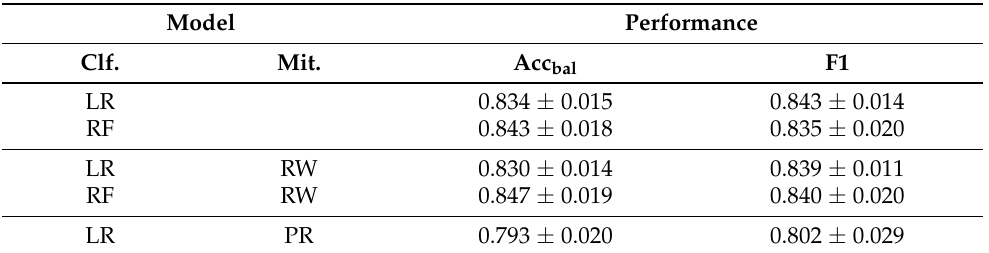
Table 4. Classification metrics for logistic regression (LR) and random forest (RF) classifiers including bias mitigation strategies reweighing (RW) and prejudice remover (PR). The classification metrics are balanced accuracy (Acc bal ) and F1 score. The errors shown are standard deviations.